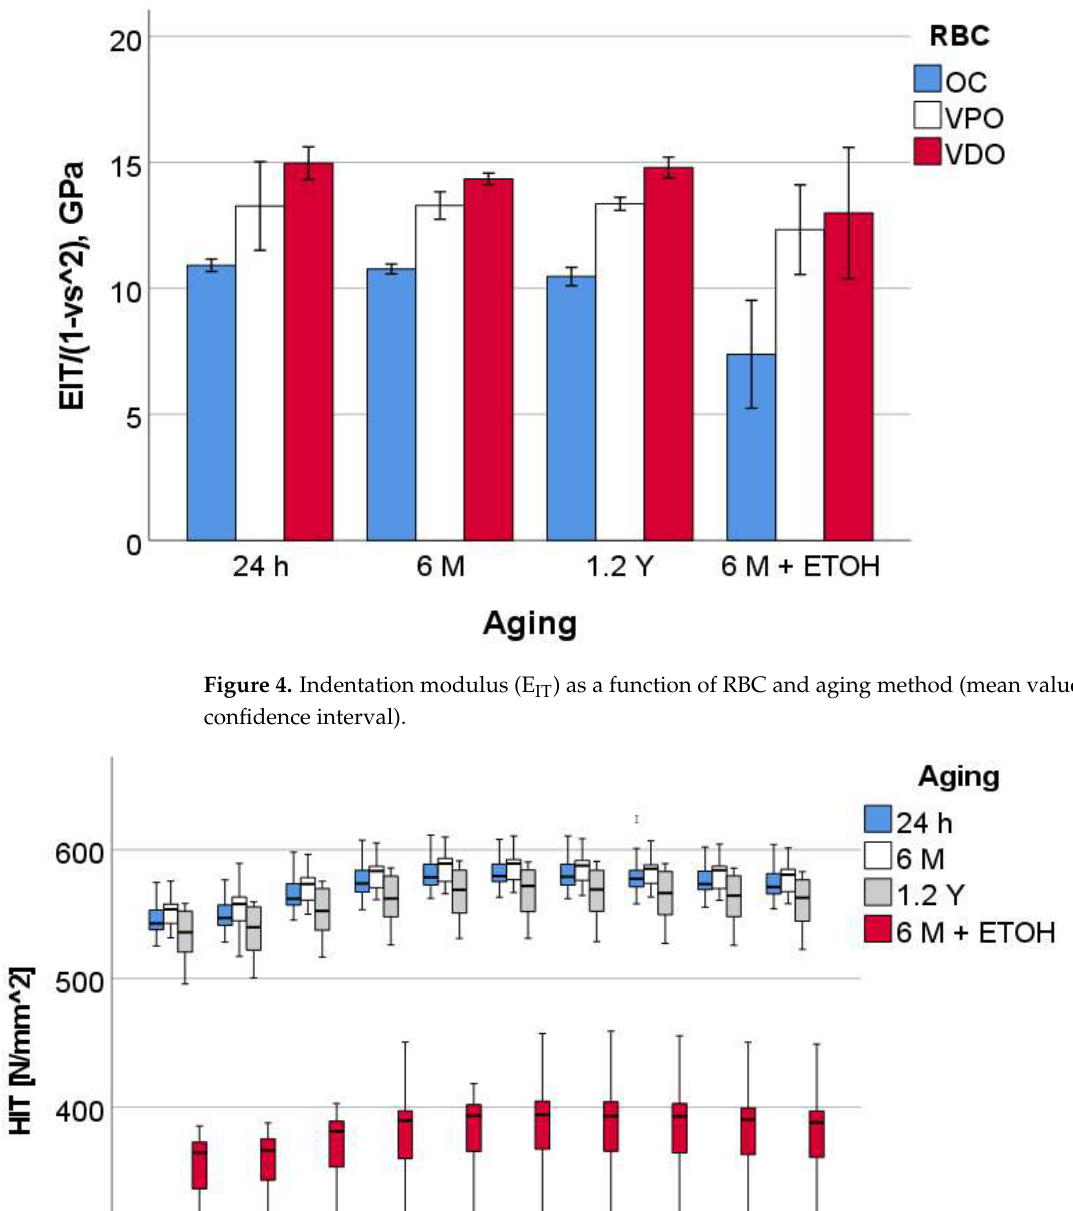
Table 3. Multivariate analysis (general linear model) and the effect strength of the main factors— aging method, RBC, and frequency—on the parameters tested. All effects were statistically signifi- cant ( p < 0.001); partial eta-squared (η P ²) values are given.